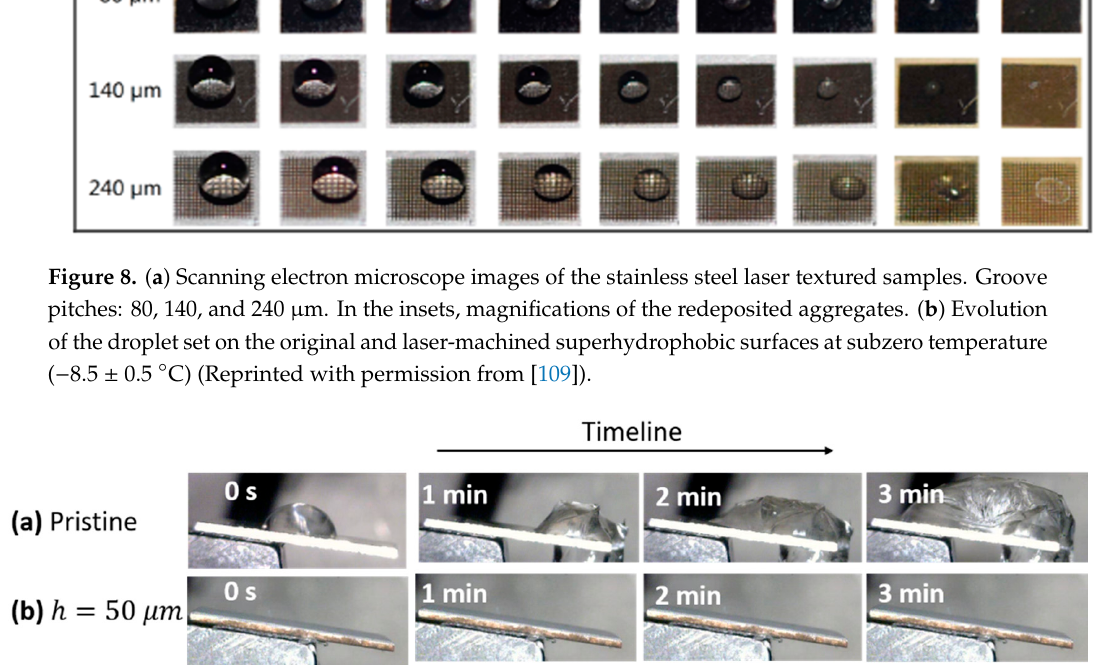
Figure 8. ( a ) Scanning electron microscope images of the stainless steel laser textured samples. Groove pitches: 80, 140, and 240 μ m. In the insets, magnifications of the redeposited aggregates. ( b ) Evolution of the droplet set on the original and laser-machined superhydrophobic surfaces at subzero temperature ( − 8.5 ± 0.5 °C) (Reprinted with permission from [109]).